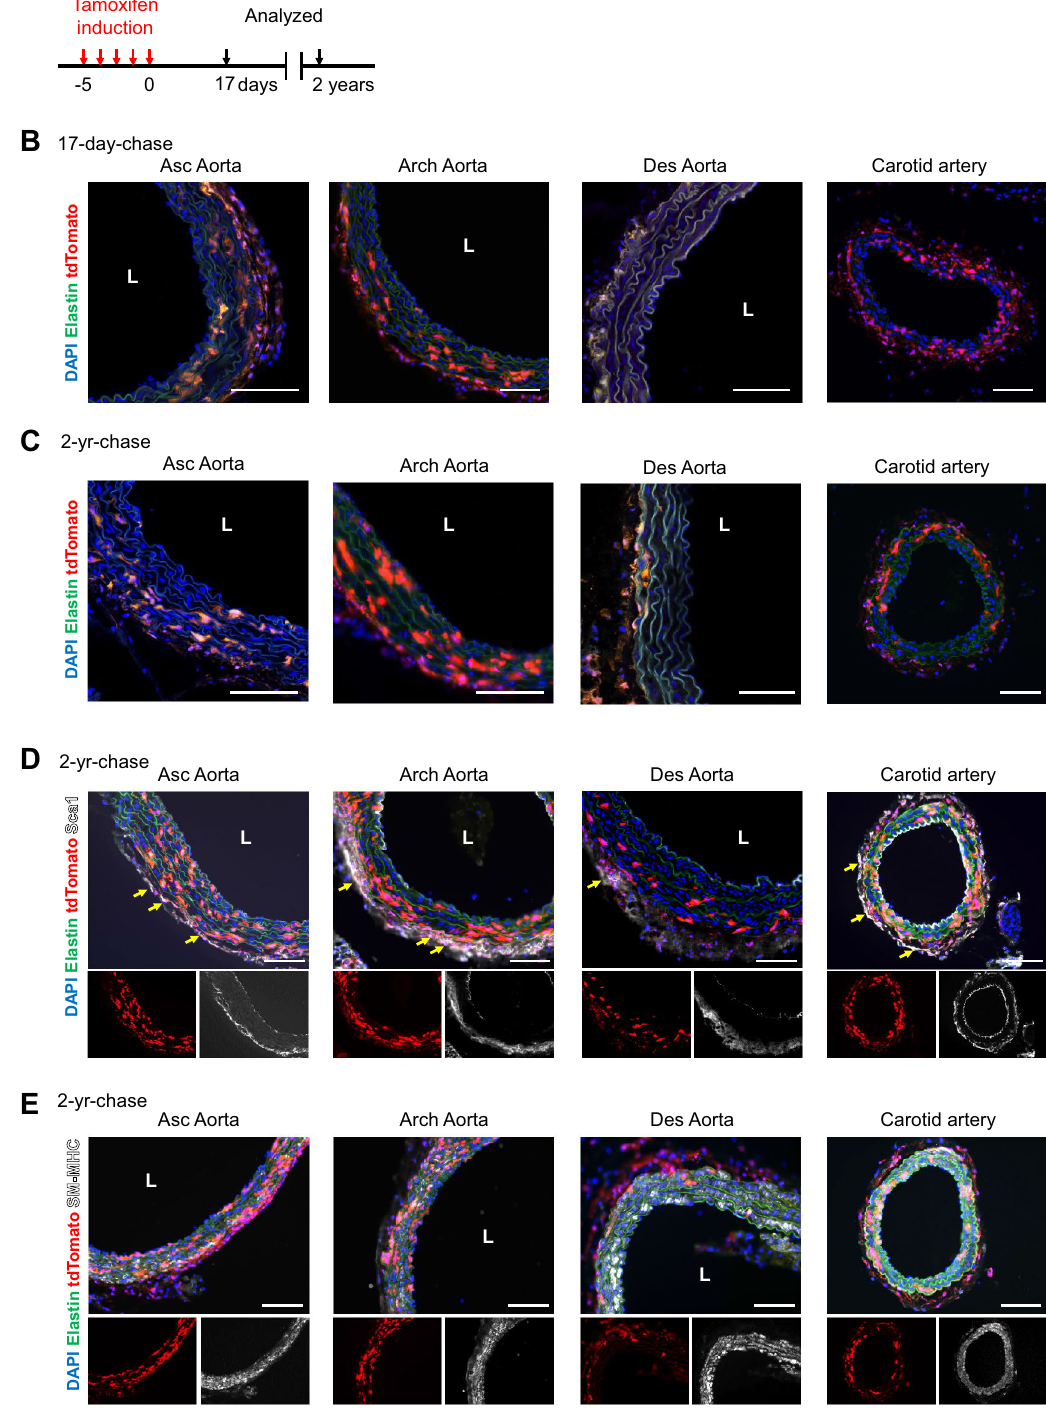
Figure 2. The fate of of PDGFRa+ cells during a long-term homeostasis of the aortic wall. ( A ) Schematic outlining the experimental strategy. ( B ) Representative images of the initial labeling at 2 months of age in different portions of large arteries. L: lumen, Asc Aorta: ascending aorta, Des Aorta: descending aorta. Scale bars: 100 µm. ( C ) Representative images of 2-year-chase in different portions of larger arteries. L: lumen, Asc Aorta: ascending aorta, Des Aorta: descending aorta. Scale bars: 100 µm. ( D , E ) Immunostaining for Sca1 ( D ) and SM-MHC ( E ) in the aortas at 2-year-chase. Arrows indicate tdTomato+ /Sca1+ adventitial cells. L: